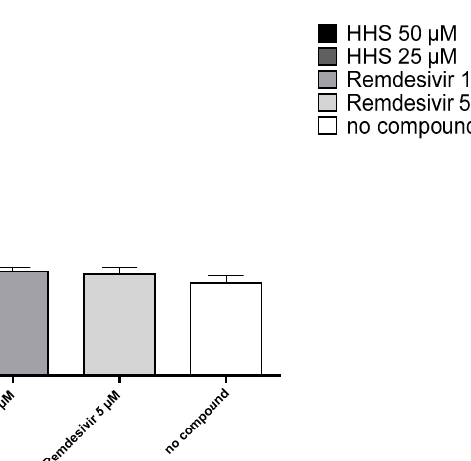
infection. Compounds were then washed away and the cells were further incubated in medium (MEM 2% FCS) only. After 24 h, the cell supernatant was removed and tested by qPCR as described above. Values for the viral uptake inhibition represent the CT values (means ± SD) of five